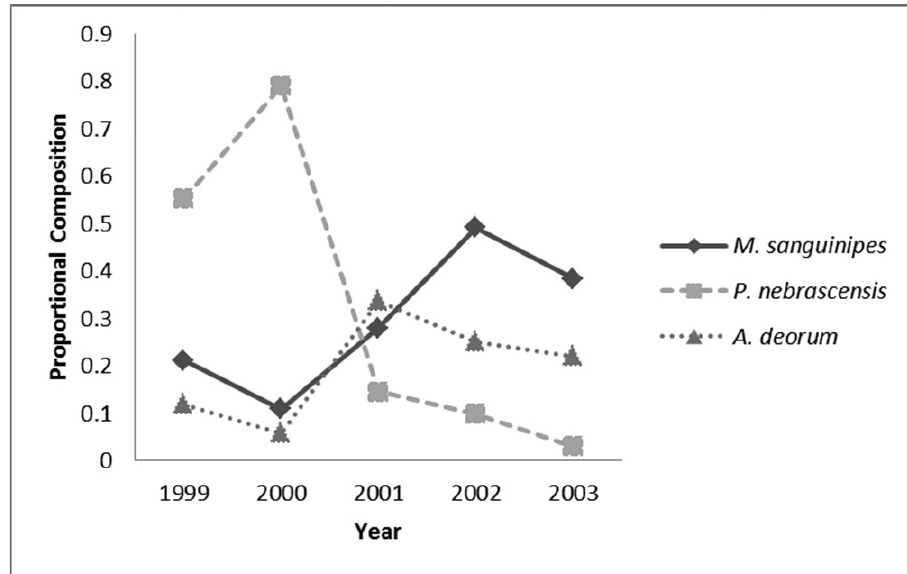
Figure 1. Proportional composition for each of the three major grasshopper species averaged across random catches in a given year from 1999 to Table 1. A. Peak total and common species grasshopper densities from 1999 to 2003. B. Green grass biomass (g/m 2 ) in late June or early July (Mid-summer) in all years and late August or early September (Late-summer) from 1999 to 2001. C. Grass percent nitrogen content in mid-summer and late summer. * Indicates missing data.